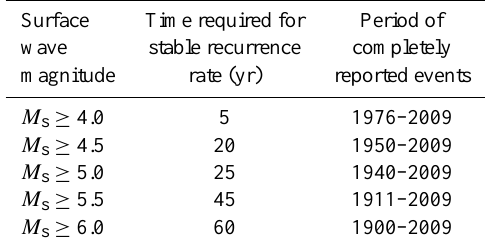
Table 1. Results of the completeness test of the Makropoulos et al. (2012) instrumental earthquake